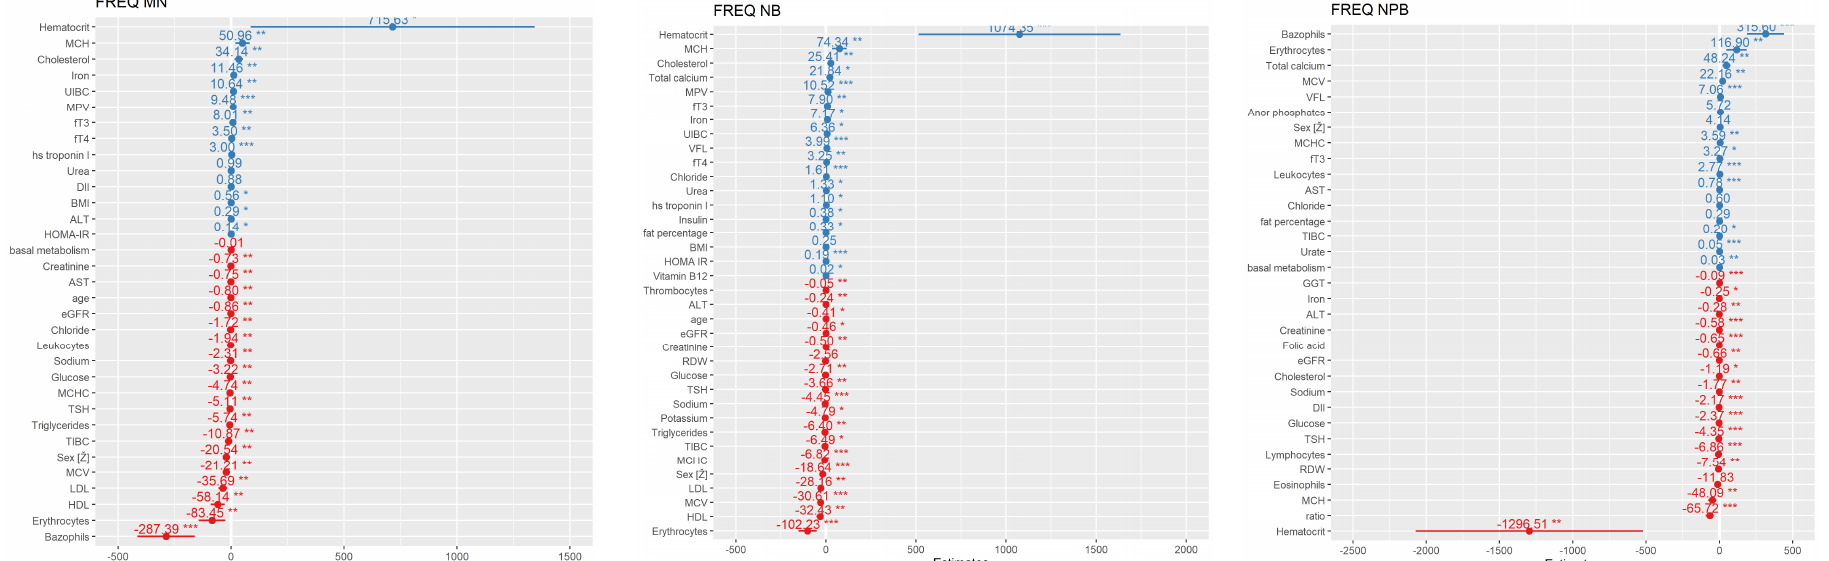
Figure 8. Stepwise regression model for DNA damage prediction of micronucleus (MN), nuclear bud (NB) and nucleoplasmic bridge (NPB) frequency in MN cytome assay for obese group of people with BMI ≥ 35 kg m − 2 based on the biochemical and anthropometric parameters used in the study. Values are categorized by coefficient estimates for DNA damage prediction, while p values are responding to the importance of each variable for model prediction. Negative values have negative correlation (red) and positive values have positive correlation with TI (blue) *— p -value < 0.05, **— p -value < 0.01, ***— p -value < 0.001.